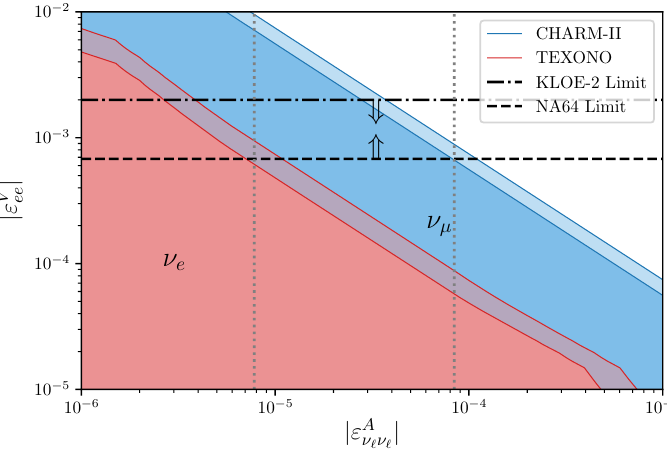
Figure 3 . New (cid:31) 2 -(cid:12)t of the (cid:22) (cid:23) e e scattering data of TEXONO (red) and the (cid:22) (cid:23) (cid:22) e scattering data of CHARM-II (blue), displaying the 1- and 2- (cid:27) allowed regions around the best (cid:12)t point (respectively darker and lighter colours). The lower bound of NA64 (dashed line) and the upper bound by KLOE- 2 (dash-dotted line) are also shown, with the arrows identifying the viable allowed regions. The obtained upper limits on the axial coupling to neutrinos, cf. eq. (5.7), are marked by dotted